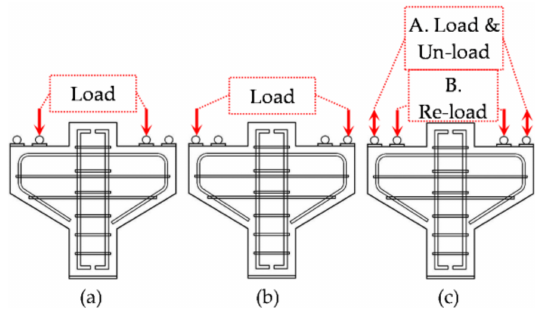
Figure 3. Experimental specimens in the first series: ( a ) D-C, ( b ) PE-C, and ( c )